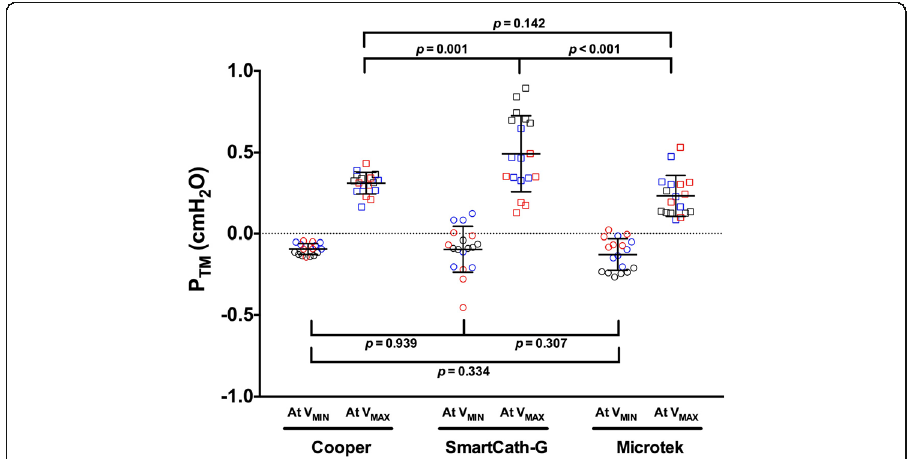
Fig. 5 Balloon transmural pressure under all bench conditions. Balloon transmural pressure ( P TM ) at minimal ( V MIN ) and maximal balloon inflating volume ( V MAX ) under atmosphere ( black ) and end-expiratory ( blue ) and end-inspiratory occlusion ( red ) during simulated passive ventilation. All P TM were within ±1 cmH 2 O. Mean and standard deviation are also